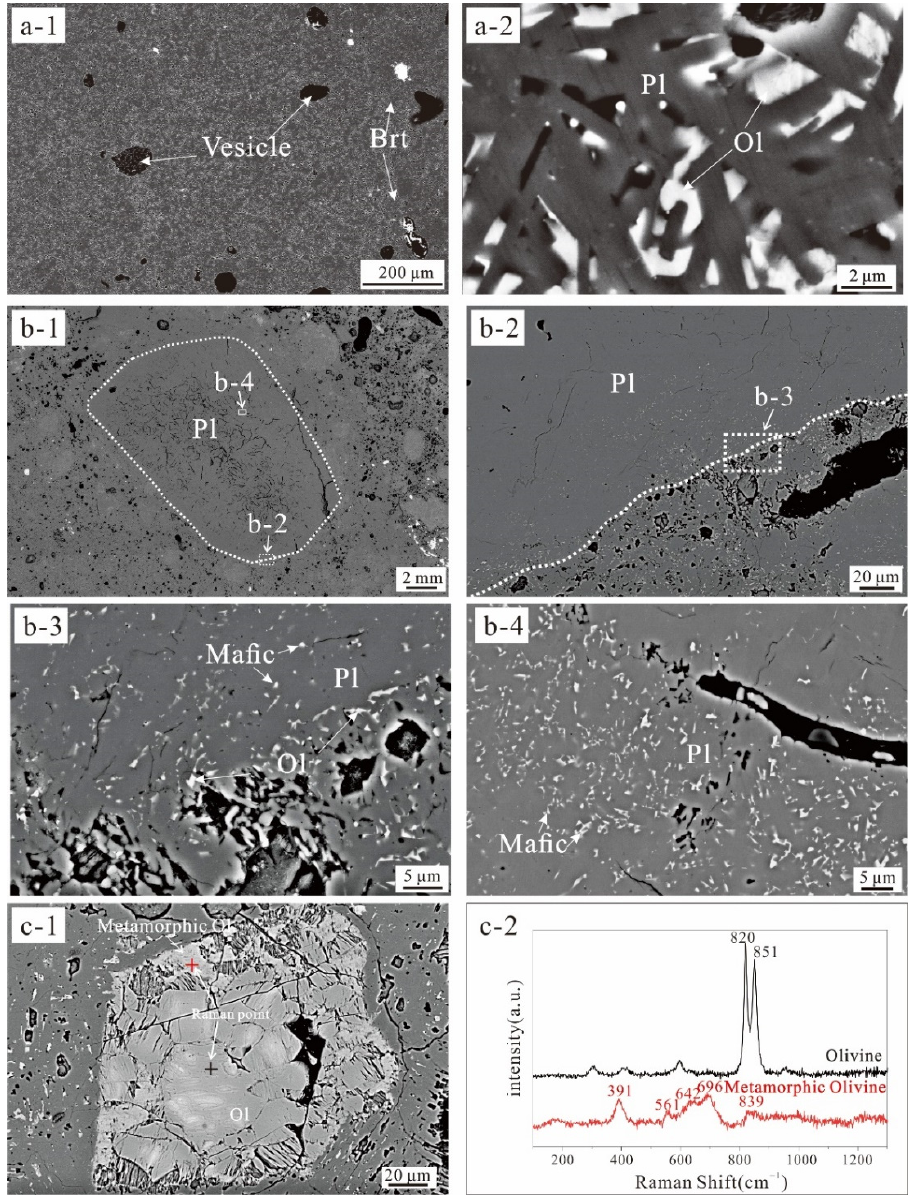
Figure 7. Backscatter electron images and Raman data of the matrix and mineral fragments. ( a ): the matrix. ( a-1 ): Vesicles in the matrix and some are filled with barite (Brt); ( a-2 ): Enlarged photograph of ( a-1 ), showing that the matrix is composed of plagioclase and olivine microcrystals with a poikilitic-like texture. ( b-1 ): The biggest plagioclase mineral fragment (about 8 mm) in NWA 13120; ( b-2 ): Enlarged photograph of ( b-1 ), showing the edge of plagioclase fragment; ( b-3 ): Enlarged photograph of ( b-2 ), showing that the plagioclase microcrystals in plagioclase fragments and matrix are continuous and the boundary is not clear; ( b-4 ): Enlarged photograph of the core of plagioclase in ( b-1 ), showing microcrystal plagioclases and mafic minerals with a poikilitic-like texture. ( c-1 ): The edge of the olivine mineral fragment was metamorphic and the different colored crosses correspond to the Raman data in ( c-2